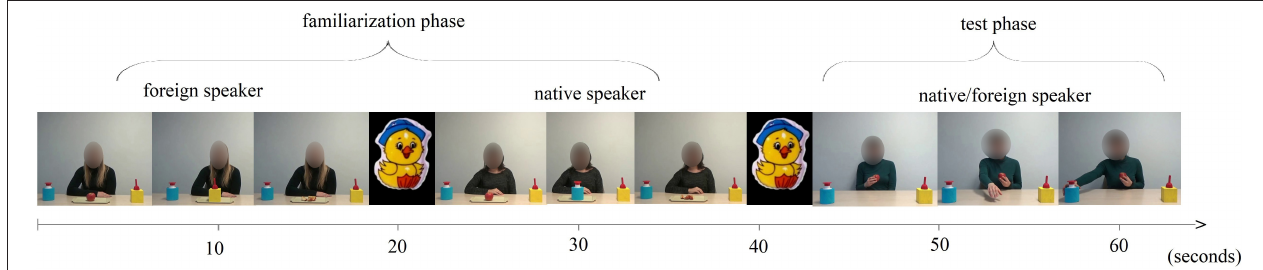
FIGURE 2 | Video stimuli. Picture depicts the video that were used during the experiments. The order of appearance of the native and foreign speaker models was counterbalanced during the familiarization phase. The model during the test phase spoke either in children’s native or in a foreign language.